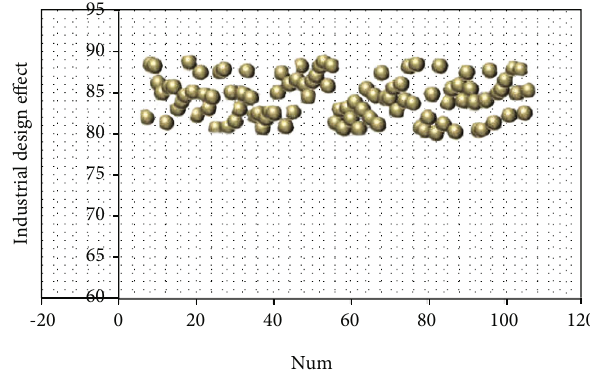
Figure 12: E ff ect evaluation of intelligent industrial design system based on spatial digital